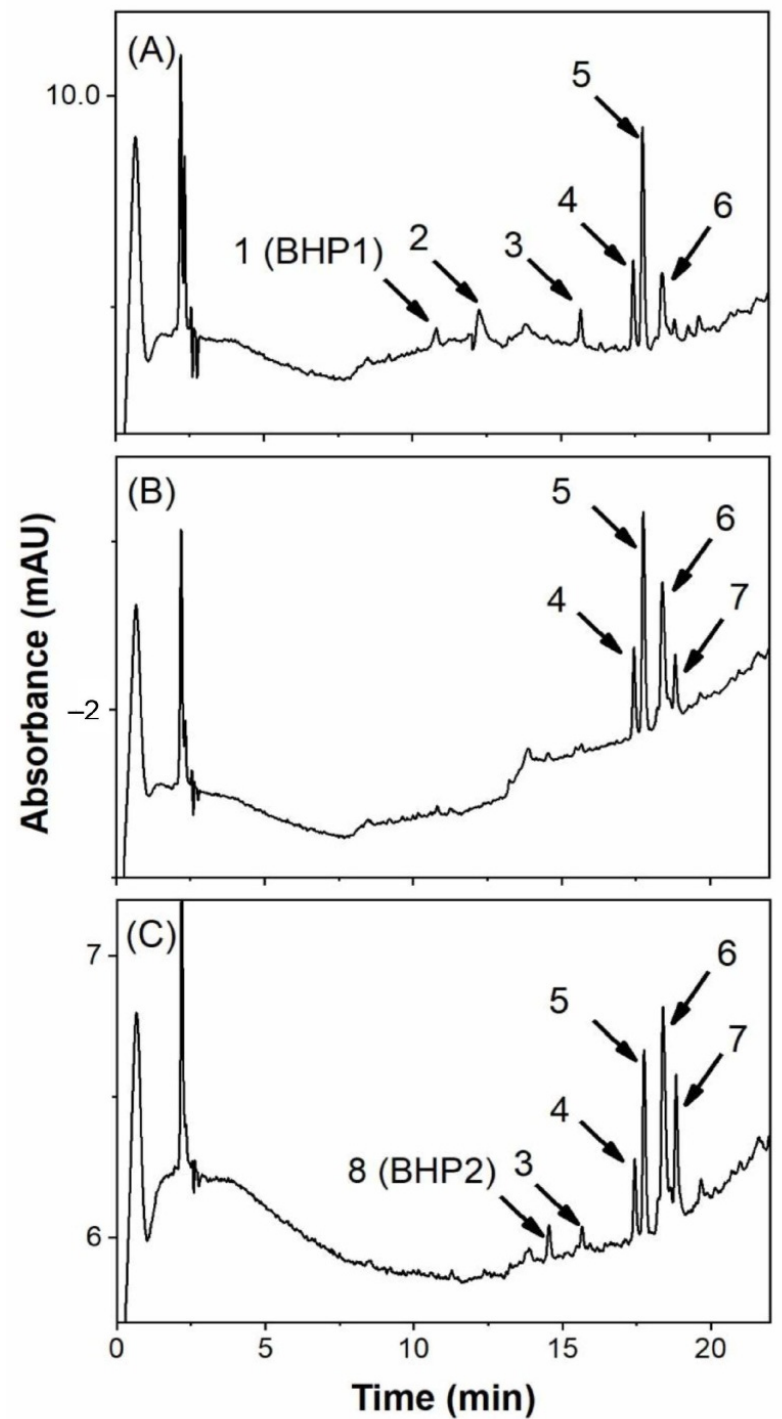
Figure 1. Typical HPLC chromatograms of the reaction mixtures of BR (200 μ M) and H 2 O 2 (1.0 mM) under in vitro physiological conditions (pH 7.4, 37 °C) for 48 h. The chromatogram was presented at ( A ) 260, ( B ) 280, and ( C ) 300 nm.